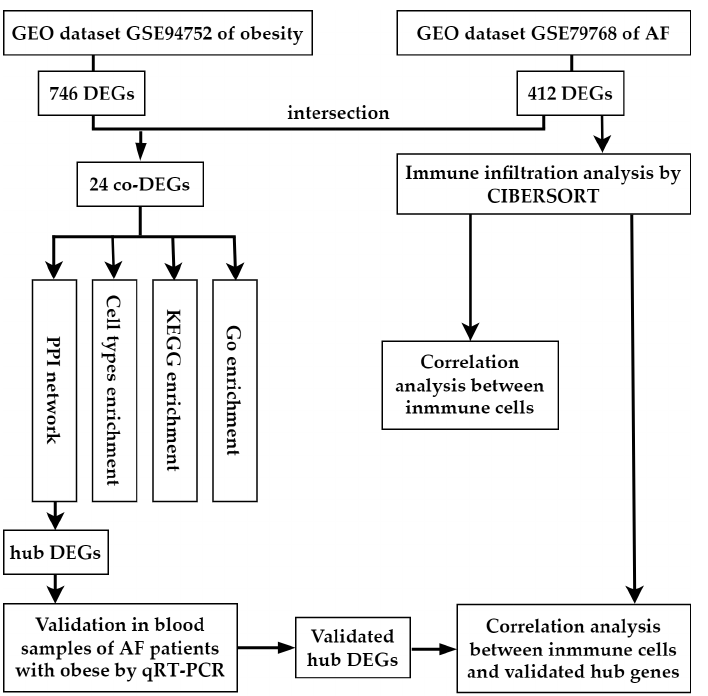
Figure 1. Workflow of the bioinformatics analysis methods in the present study. GEO, Gene Expres- sion Omnibus; AF, arial fibrillation; DEGs, differentially expressed genes.